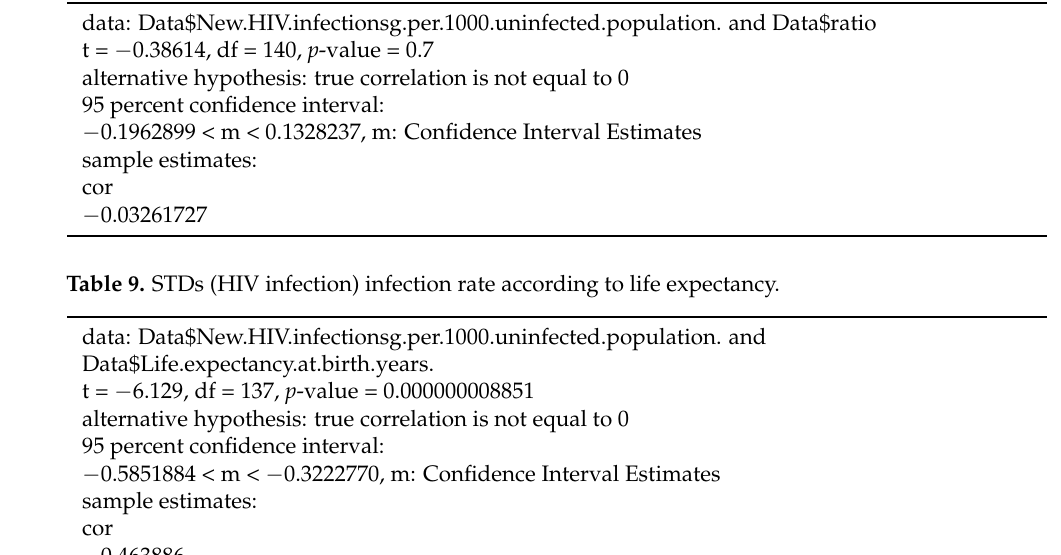
Table 8. STDs (HIV infection) infection rate according to gender ratio. data: Data$New.HIV.infectionsg.per.1000.uninfected.population. and Data$ratio t = − 0.38614, df = 140, p -value = 0.7